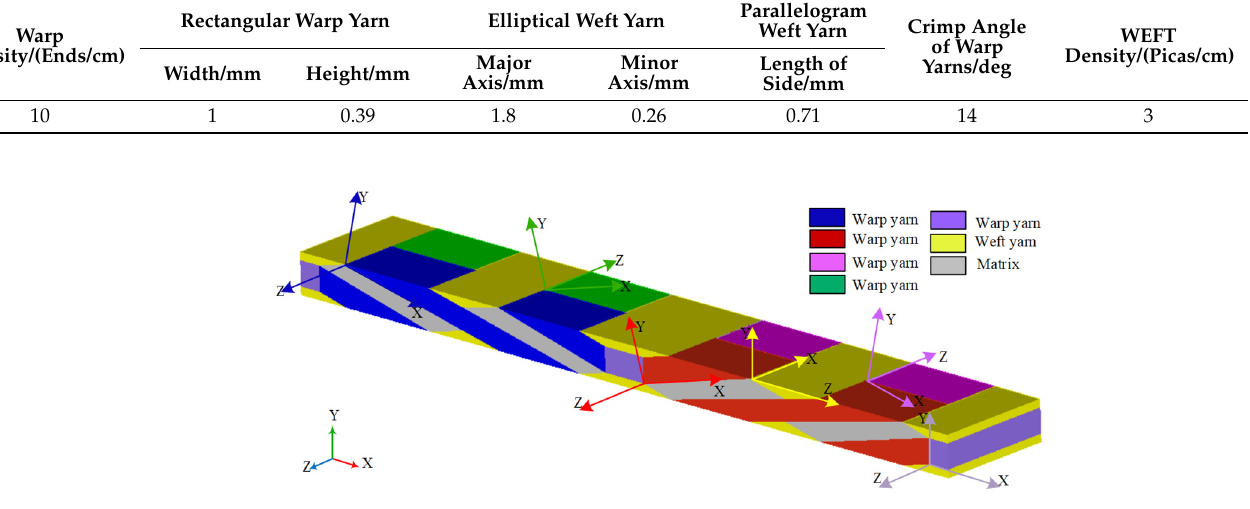
Table 1. Geometrical parameters of weave architecture in 2.5D RVE.